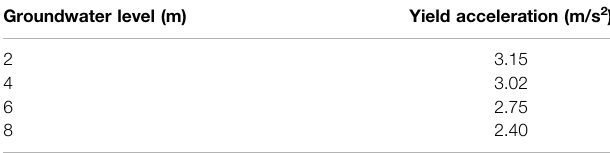
TABLE 2 | Yield acceleration of the bank slope at different groundwater levels. Groundwater level (m)